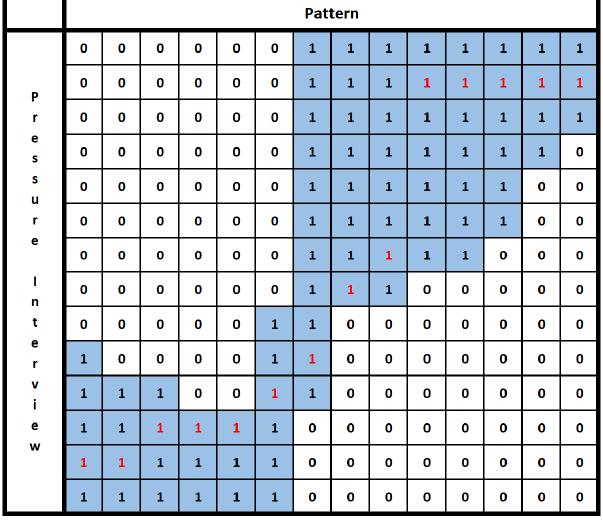
Figure 9. Pre-define pattern for build-up break